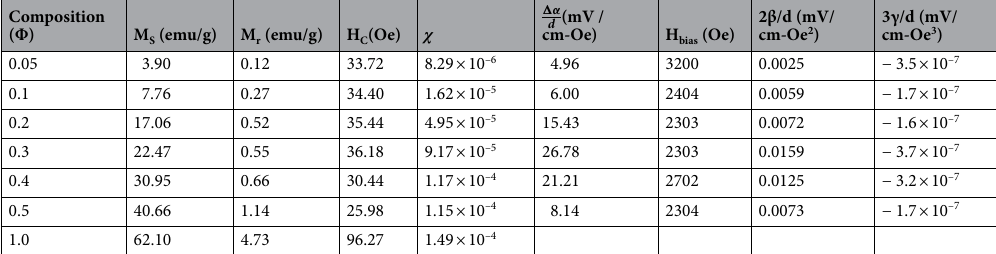
Table 3. The magnetic parameters (obtained from the fitting of M-H loop) and obtained values of �α d , H bias , 2β/d and 3γ/d parameters for the composites (obtained from magnetoelectric coupling